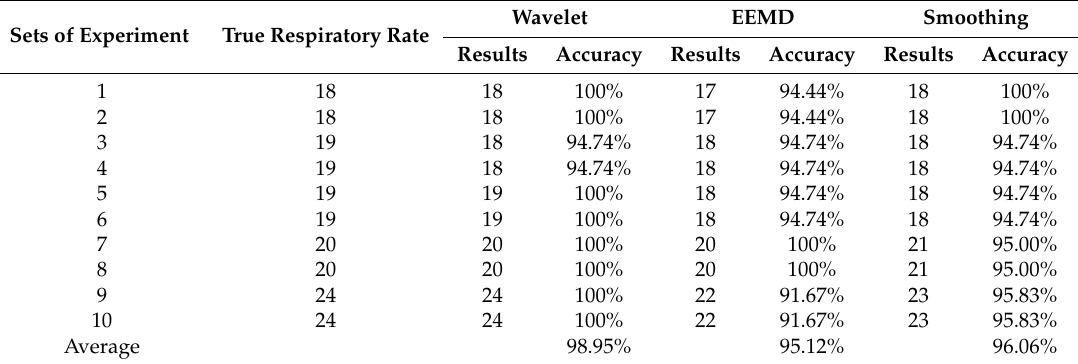
Table 1. The results of the respiratory rate test with the time period of 60 s.